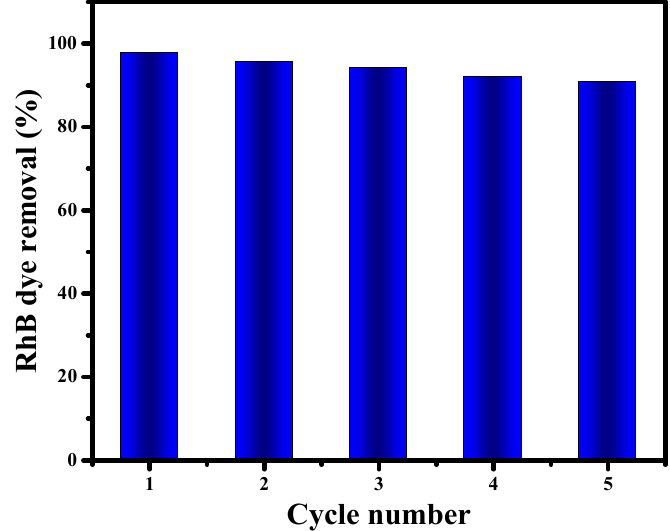
Figure 9. Reuse investigations for the regenerated MgTiO 3 @g-C 3 N 4 in removing RhB.